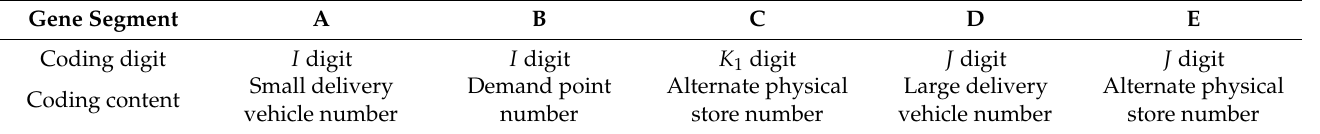
Table 3. Chromosome coding